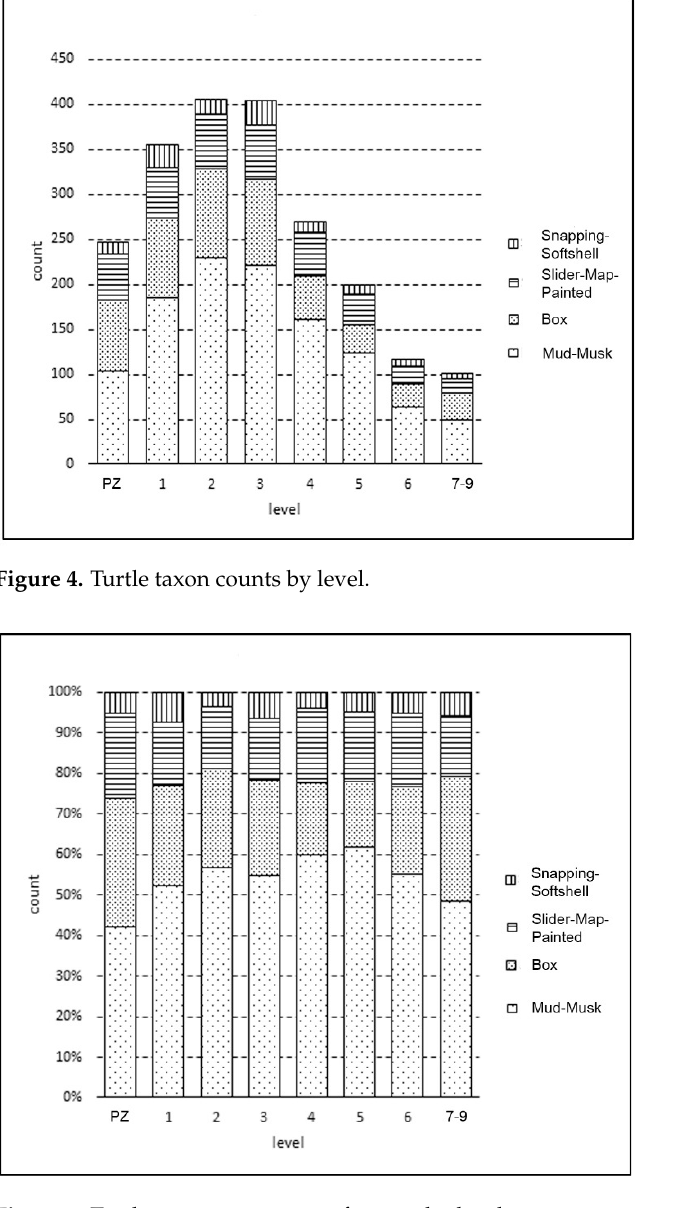
Figure 5. Turtle taxon percentage of counts by level.